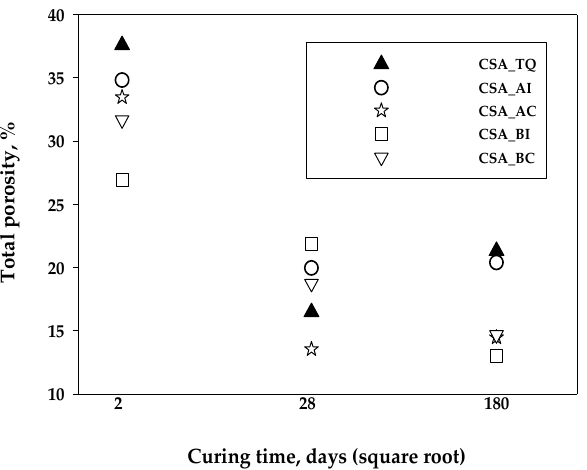
Figure 10. TPP for R_C, R_AI, R_AC, R_BI and R_BC hydrated pastes (w/b = 0.5) between 2, 28 and 180 days.